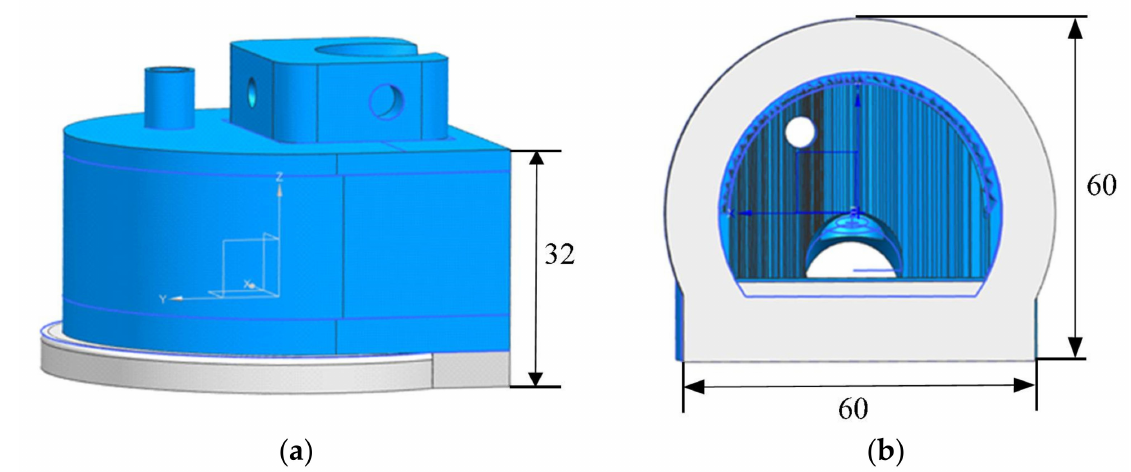
Figure 3. Designed shell from ( a ) the side view and ( b ) the bottom view.